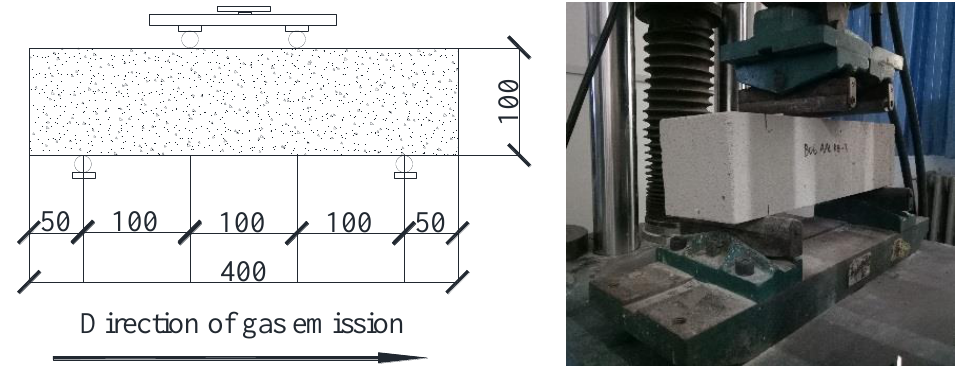
Figure 4. Flexural strength loading device. (Units in mm).